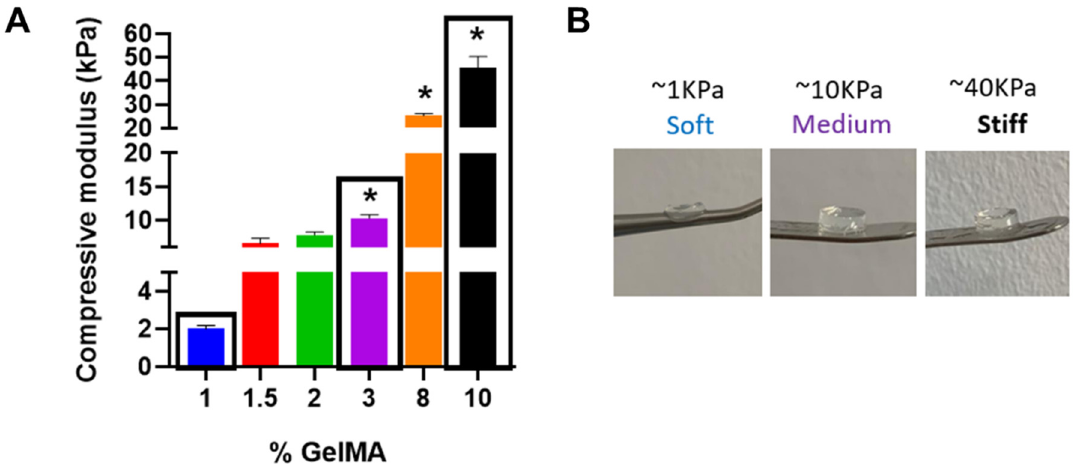
Figure 1. ( A ) Effect of increasing concentrations of GelMA on the compressive modulus of the hydrogels. The compressive modulus increased with increasing GelMA concentration. Hydrogels containing 3%, 8% and 10% GelMA had a significantly higher compressive modulus compared with 1% GelMA hydrogels (* p < 0.05). ( B ) Images of selected soft (2%), medium (3%) and stiff (10%) GelMA hydrogels.